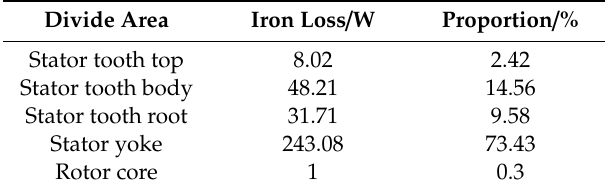
Table 3. Stator core loss distribution of motor during no-load